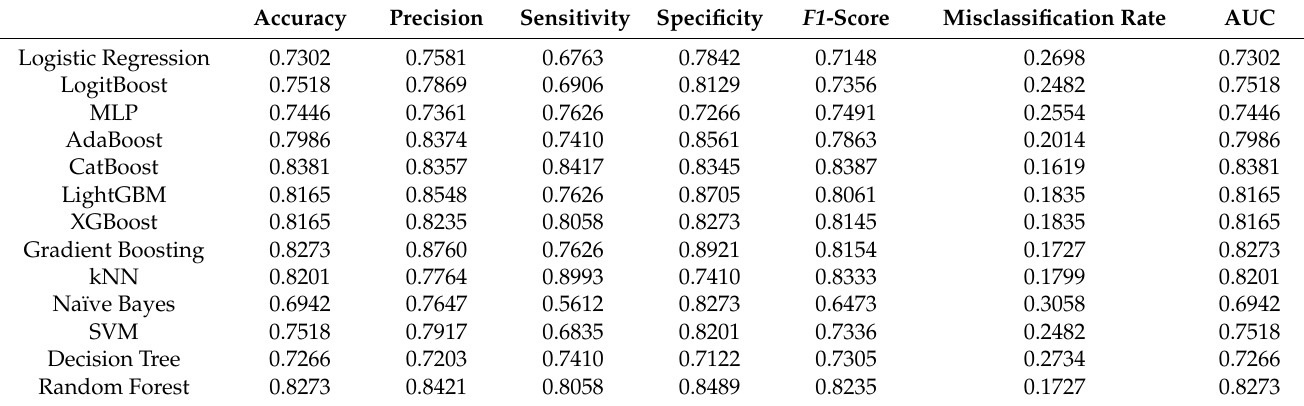
Table 7. Performances of the model during training.